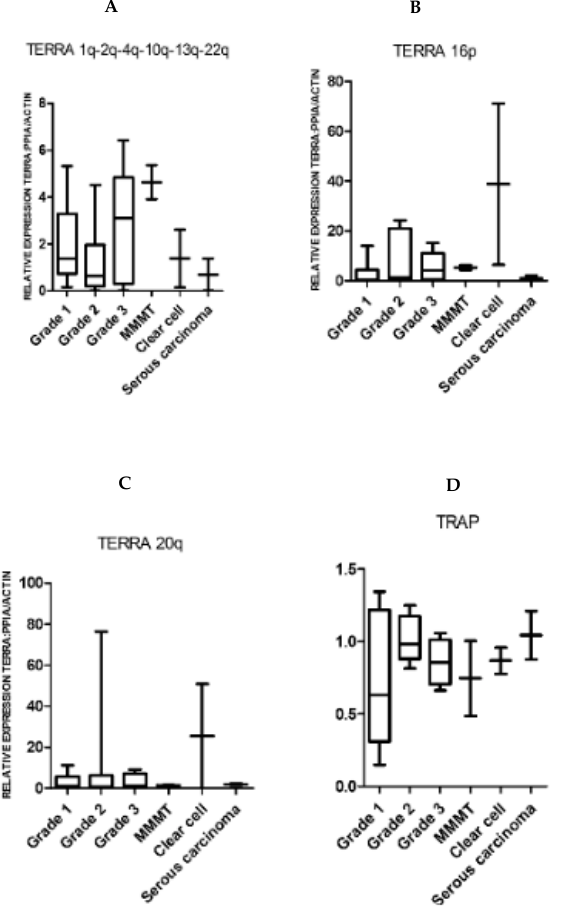
Figure 2. TERRA and TRAP levels in di ff erent grades and types of endometrial cancers. Grade 1 adenocarcinoma, n = 6; grade 2 adenocarcinoma, n = 7; grade 3 adenocarcinoma, n = 5; carcinosarcoma / malignant mixed Müllerian tumor (MMMT), n = 2; clear cell carcinoma, n = 2; serous carcinoma, n = 2. Relative normalized expression of chromosomes: 1q-2q-4q-10q-13q-22q ( A ); 16p ( B ); and 20q ( C ). TERRA levels were measured in all types of endometrial cancers. No di ff erence in TERRA levels were found in di ff erent grades of endometrioid cancers or individual subtypes of type 2 cancers. All types of endometrial cancers had high telomerase activity as assessed by TRAP assay ( D ). 2.2. Endometrial TERRA Levels Correlated with Each Other, the Proliferative Marker Ki67, Steroid Receptor PR and Shelterin Protein TRF1 but Did Not Correlate with TA or with TLs at the XpYp Chromosomes Levels of all three TERRAs demonstrated a positive correlation with each other in all endometrial samples (healthy and pathological) examined, suggesting a shared regulation (Table 1: Ch-16p and 20q, r = 0.78, p < 0.0001; Ch-16p and Ch-1q-2q-4q-10q-13q-22q, r = 0.49, p = 0.001; Ch-20q and Ch-1q-2q-4q-10q-13q-22q, r = 0.48, p = 0.001). However, TERRA levels did not correlate with TA. Ki-67 proliferative indices correlated negatively with Ch-16p and Ch-20q TERRAs (Table 1: r = − 0.35, p = 0.03; r = − 0.42, p = 0.01 respectively) suggesting a role related to cell proliferation. Ki67 scores did not correlate with Ch-1q-2q-4q-10q-13q-22q. Ch-16p TERRA also correlated negatively with the Liverpool endometrial steroid quick score (LESQS) for PR (r = − 0.40, p = 0.02) but the LESQS for other hormone receptors did not show a significant association with TERRA levels (Table 1 and Figure 3). The publicly available “The Cancer Genome Atlas” (TCGA) cohort of uterine cancers dataset suggests high expression of TRF1 gene ( TERF1 RNA) in ECs to be associated with decreased survival (Figure S1). Immunostaining quick-scores for TRF1 protein levels correlated positively with Ch-20q TERRA levels (r = 0.71, p = 0.001, Table